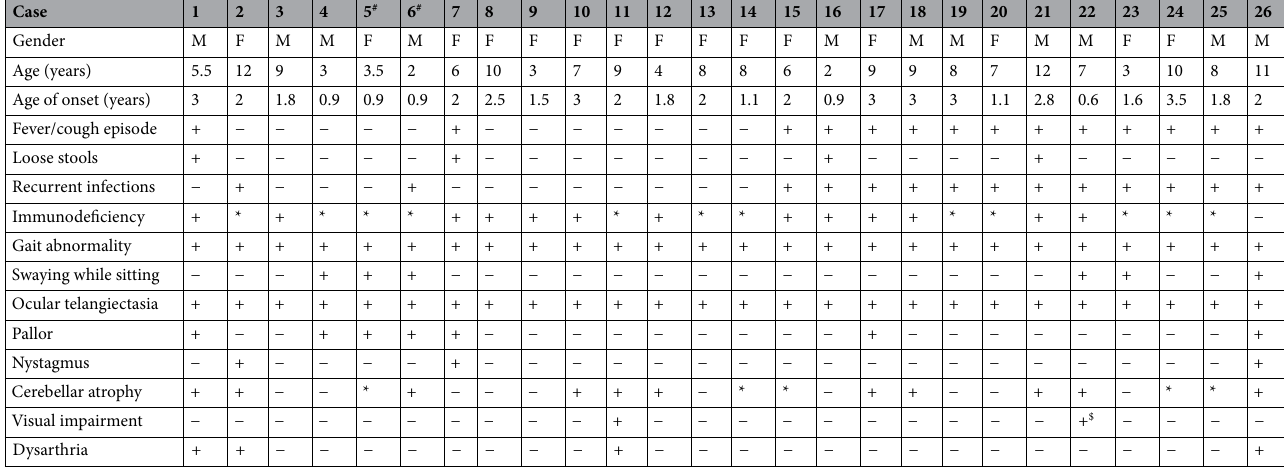
Table 1. Genetic analysis.